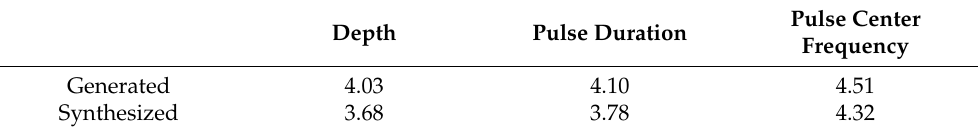
Table 4. The MOS score.